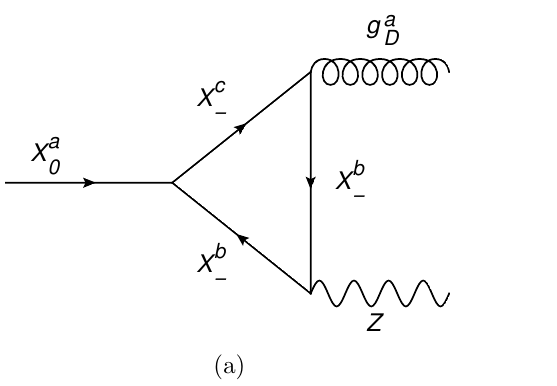
. (b) Example decay of a neutral X S nl 1